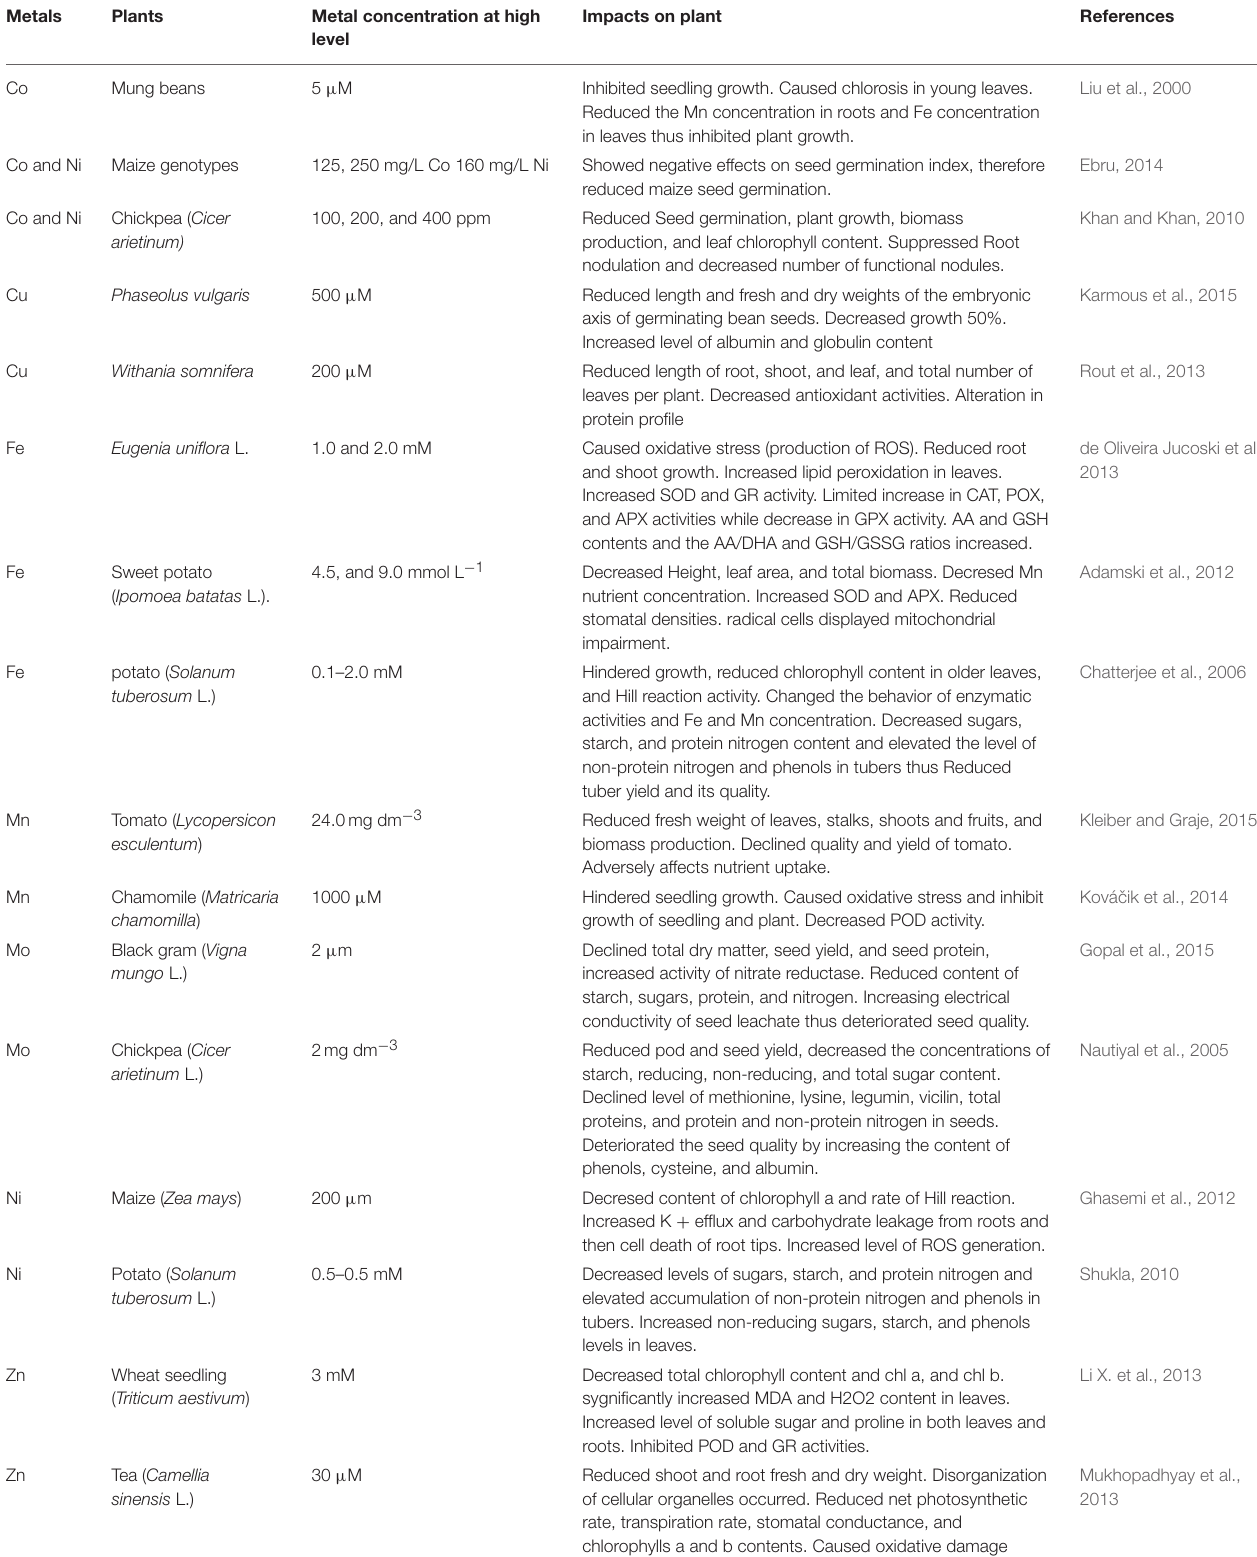
TABLE 2 | Effect of beneficial heavy metal on different plants at high